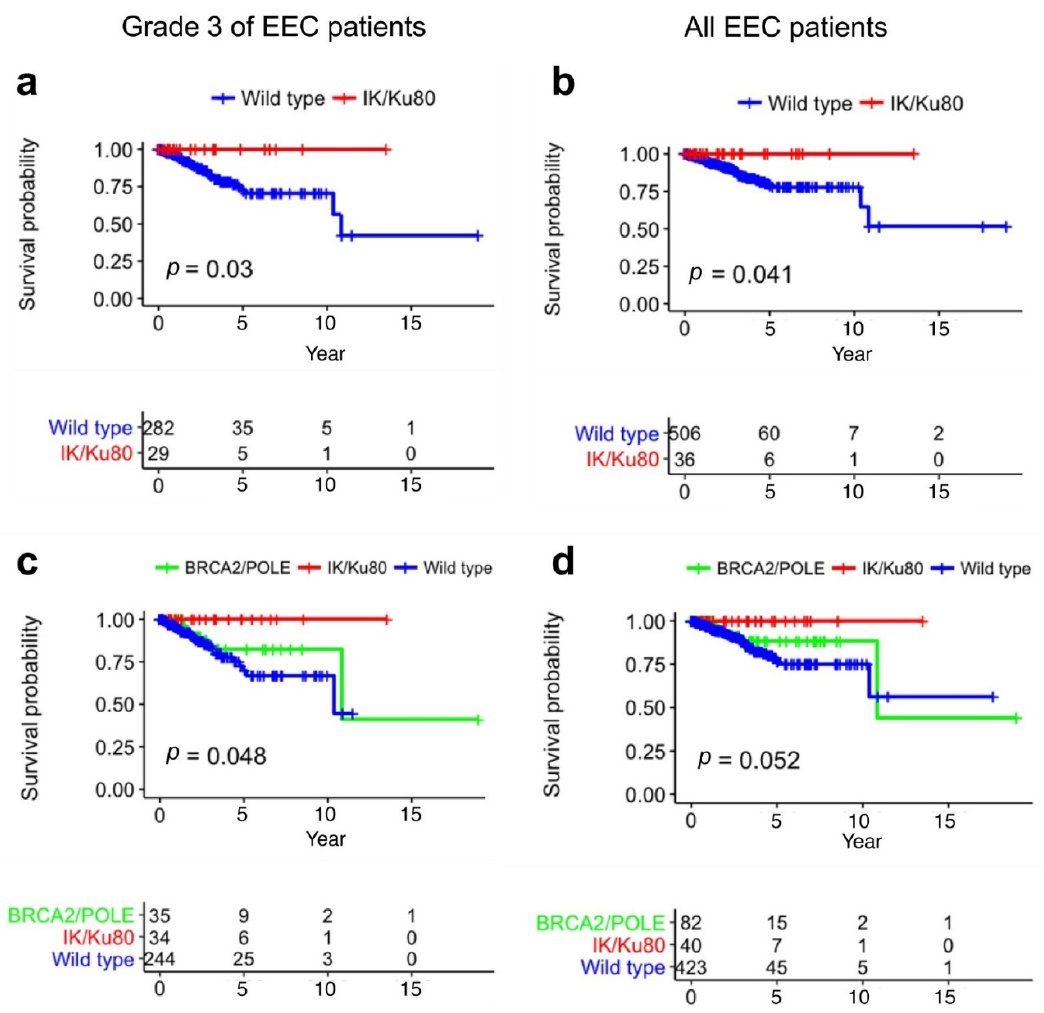
Figure 6. Survival analyses for EEC patients in TCGA differentiated by mutations of IK , Ku80 , BRCA2 , and POLE . ( a ) For EEC patients with Grade 3 disease, IK and Ku80 mutations were associated with significantly better overall survival; patients with either IK or Ku80 mutations were all alive. p = 0.03; ( b ) For all EEC patients, IK and Ku80 mutations were associated with significantly better overall survival and patients with either IK or Ku80 mutations were all alive. p = 0.041; ( c ) BRCA2 and POLE mutations were associated with significantly better overall survival in IK/Ku80 wild-type cases of Grade 3 EEC. p = 0.048; ( d ) BRCA2 and POLE mutations were associated with better overall survival in IK/Ku80 wild-type cases among all EEC patients, p = 0.052. Log-rank test.